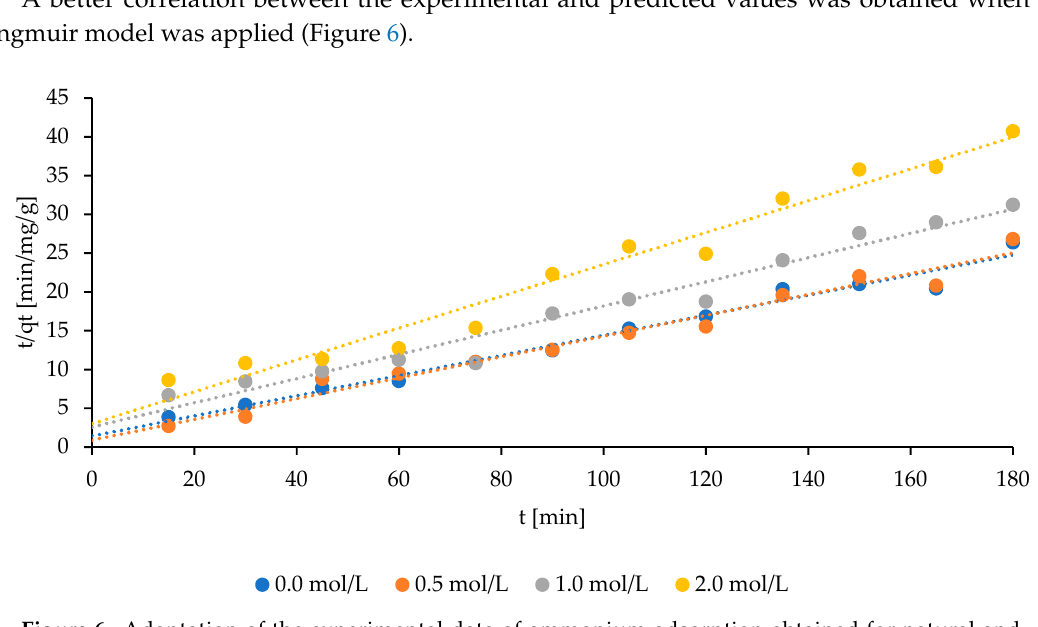
Table 3. The kinetic parameters for ammonium ion exchange using the Langmuir model (0.5M, 1M, and 2M indicate NaCl concentrations of 0.5, 1.0, and 2.0 mol/L, respectively).